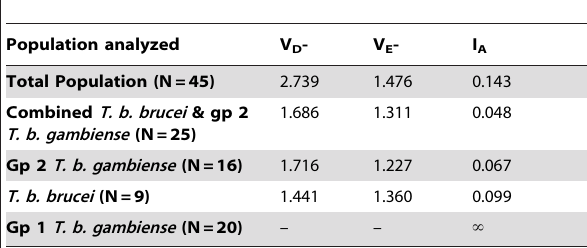
Table 8. Standardised indices of association (I A ) for the populations of group 1 and 2 T. b. gambiense and T. b. brucei at the Coˆte d’Ivoire